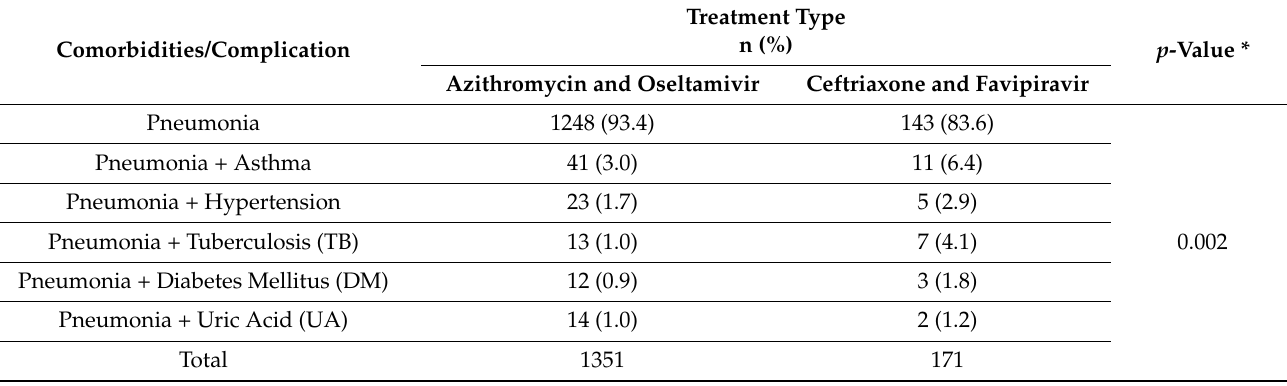
Table 2. Correlation between treatment type and comorbidity.